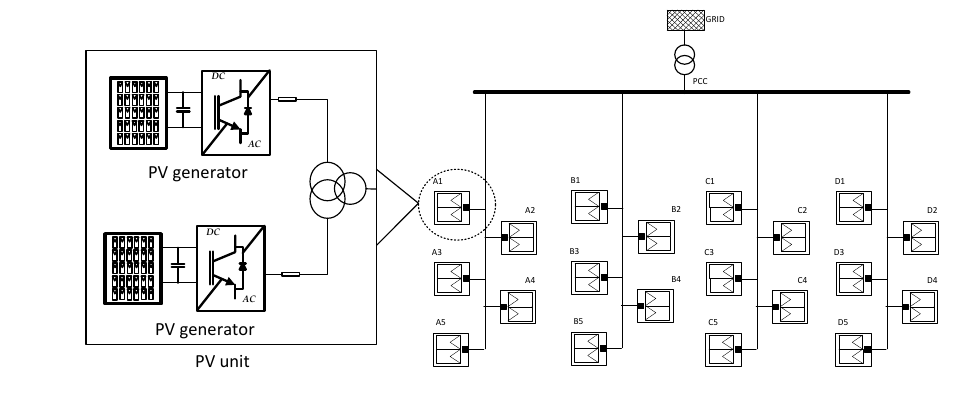
Figure 19. PVPP diagram under study.